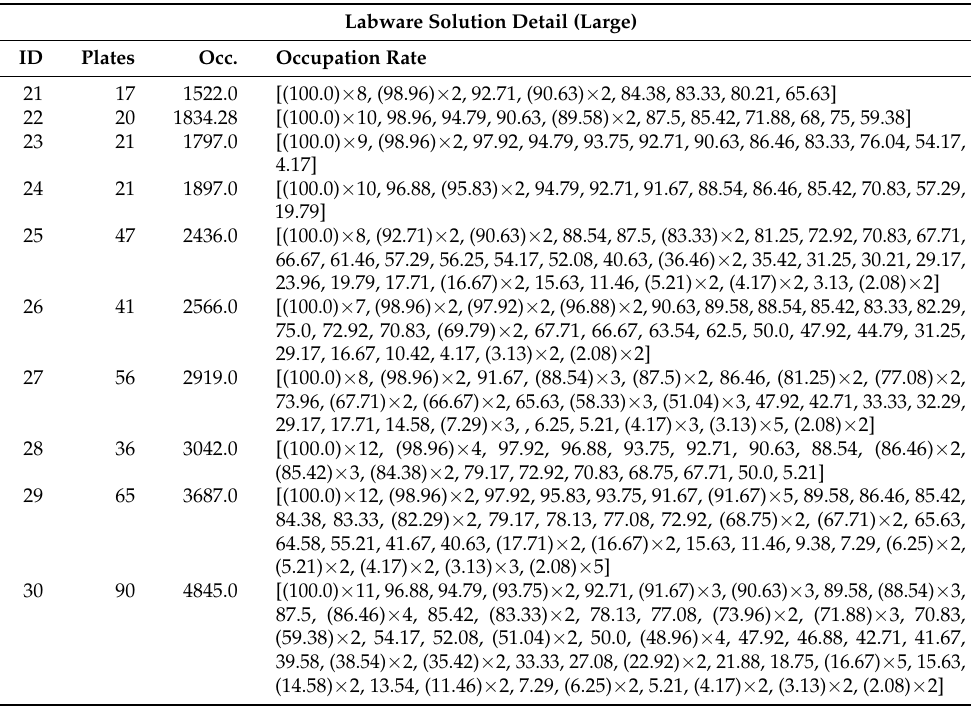
Table A4. Labware solutions detailed for big